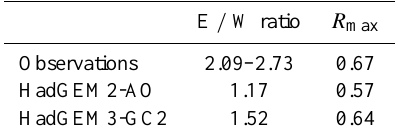
Table 2. E / W ratio in spectral power following Kim et al. (2014) and R max following Sperber and Kim (2012) for the CLIM experi- ment. GPCP (Global Precipitation Climatology Project; Adler et al., 2003) and TRMM (Tropical Rainfall Measuring Mission; Simpson et al., 1988) data are used for the observational